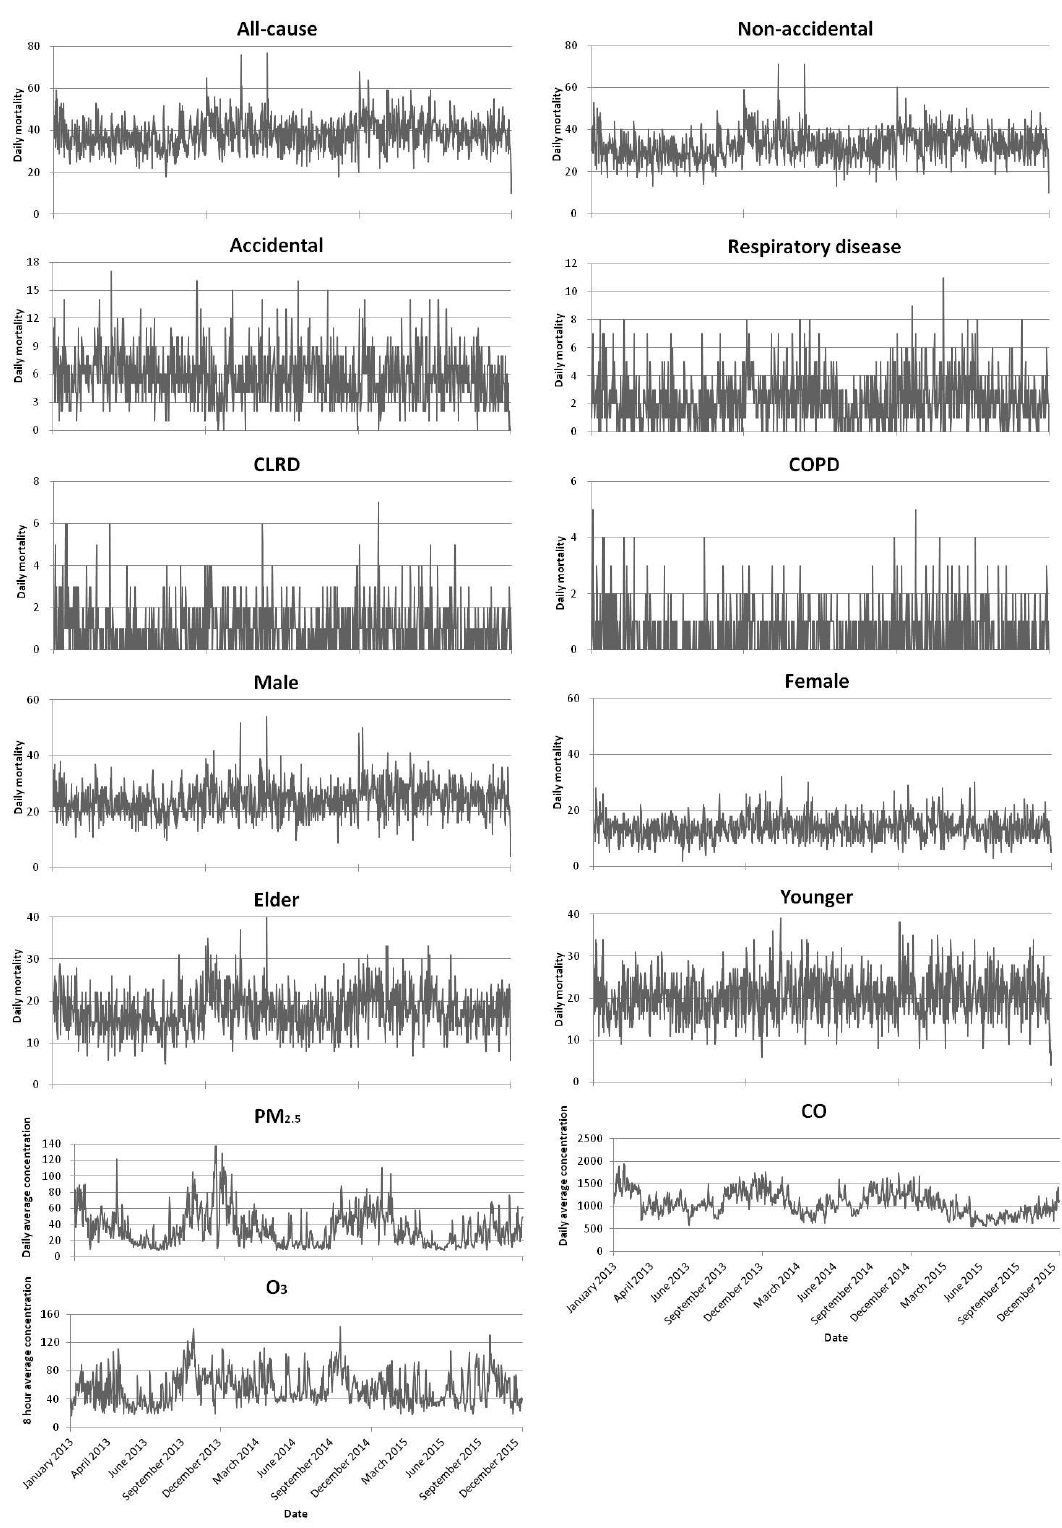
Figure 3. Time Series Chart on Residents’ Mortality versus Air Pollutants Concentration Day by Day in Shenzhen (2013–2015). CLRD = chronic lower respiratory disease; COPD = chronic obstructive pulmonary disease; Elder = age is greater than or equal to 65 years old; Younger = age is less than 65 years old.